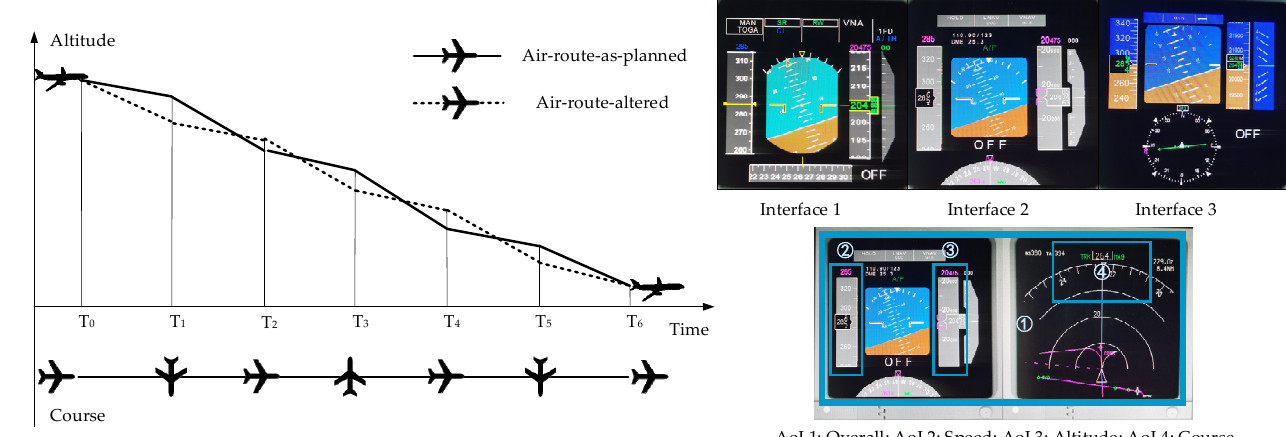
Figure 2. Experimental independent variables of air route alternation ( left ) and display design ( right ) with areas of interests (AoIs).